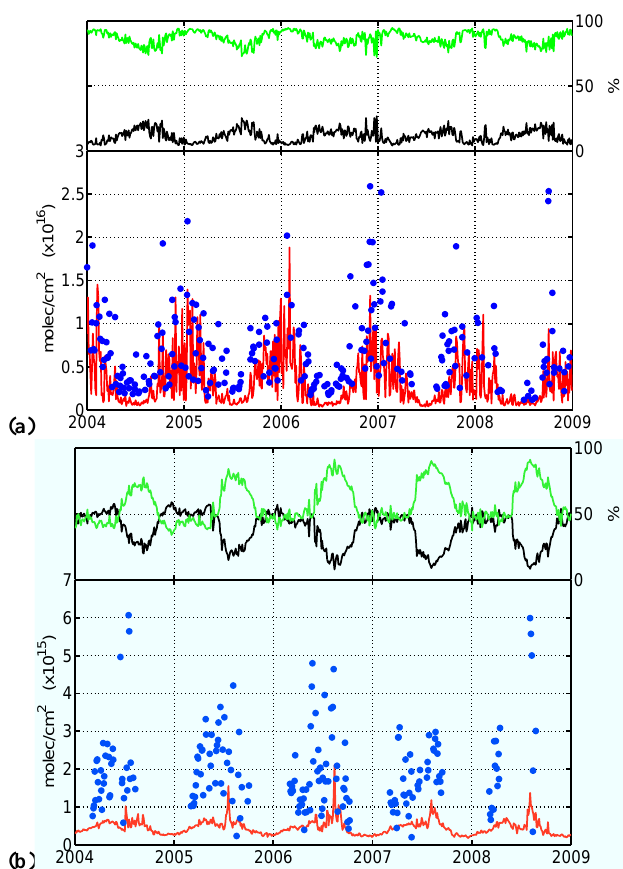
Fig. 3 : The observed seasonal cycle of FA total column (blue, lower panel) is well captured by the model at the Wollongong site (red, lower panel) and is consistent with a strong biogenic influence (green, upper panel). This is not the case in the high latitude site at Thule where model under predicts measured FA. Upper panel : modeled contribution of biogenic sources (green : emission + photochemical production) and biomass burning (black: emissions + photochemical production) to FA total column. Lower panel: modeled (red) and measured (blue) FA total column. Measurements and model are averaged over a two day time period.